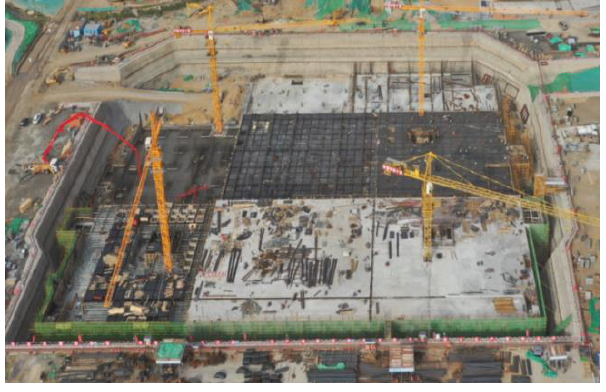
Figure 1. Construction site.